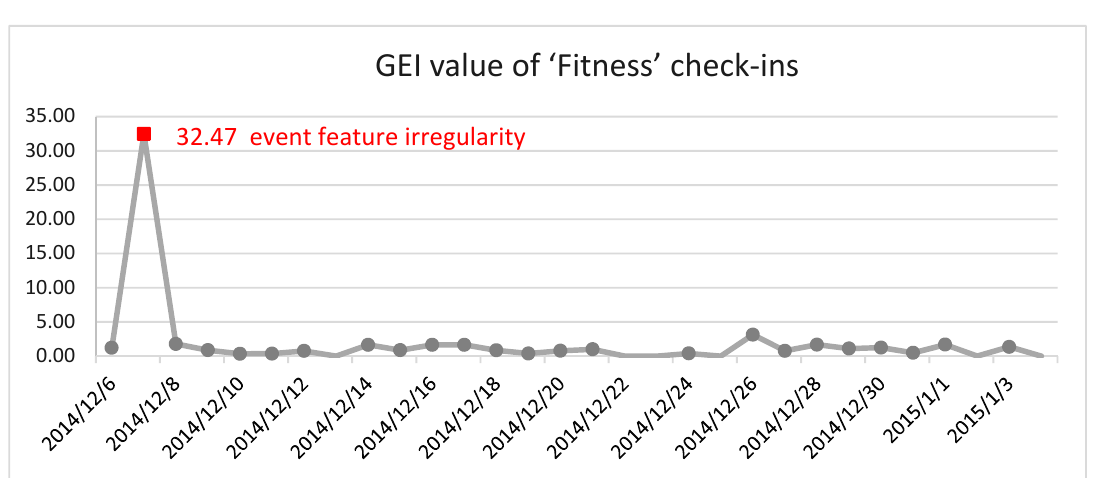
Figure 8. The detected feature irregularity of the ‘fitness’ event on 11 December 2014.